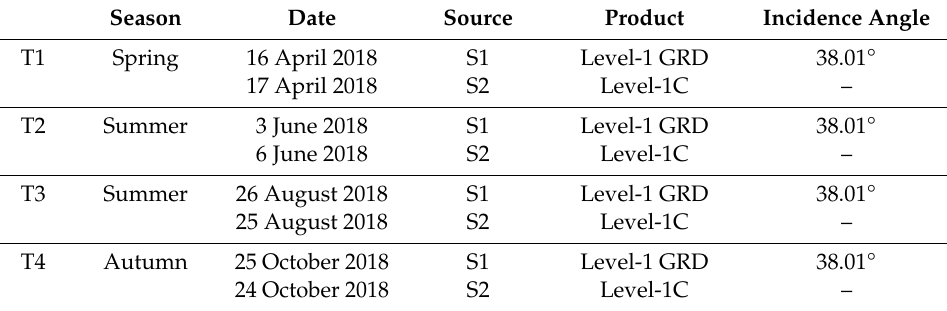
Table 2. Multitemporal Sentinel-1 / 2 data used in this study.